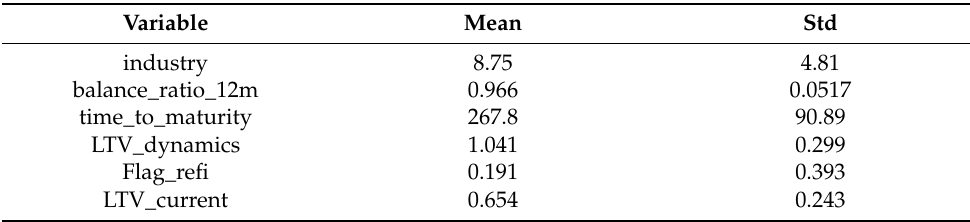
Table 2. KNN model